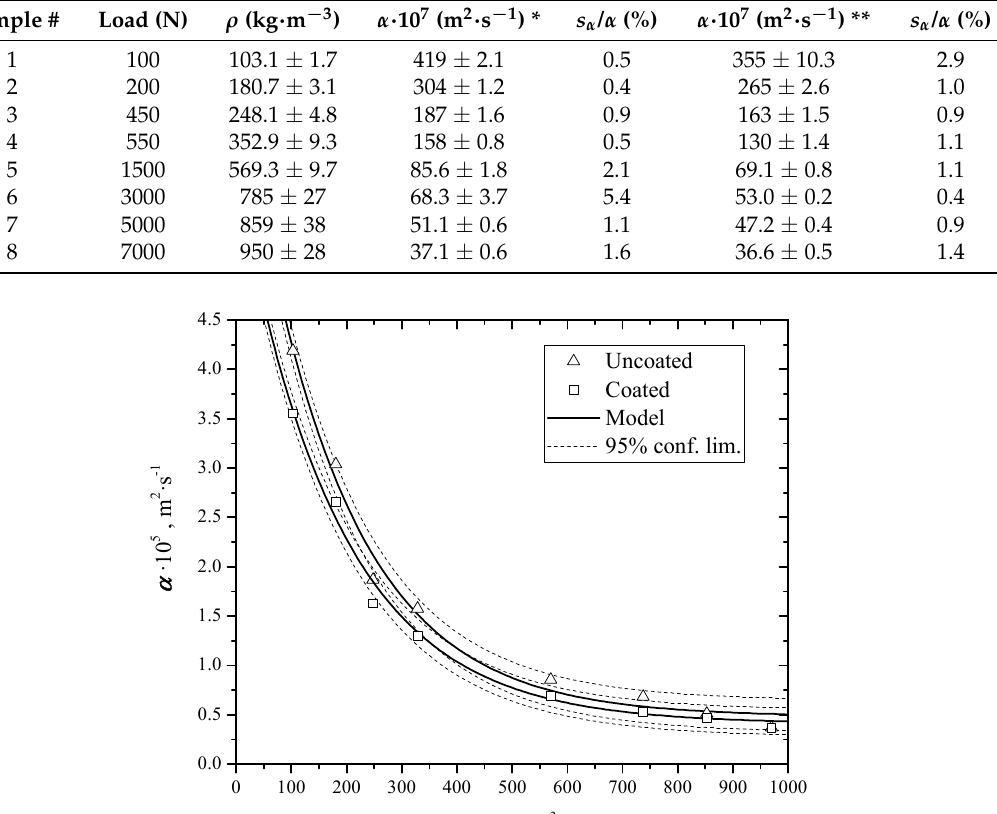
Table 2. Results of thermal diffusivity measurements of graphene samples with and without coating (* Uncoated, ** Coated).